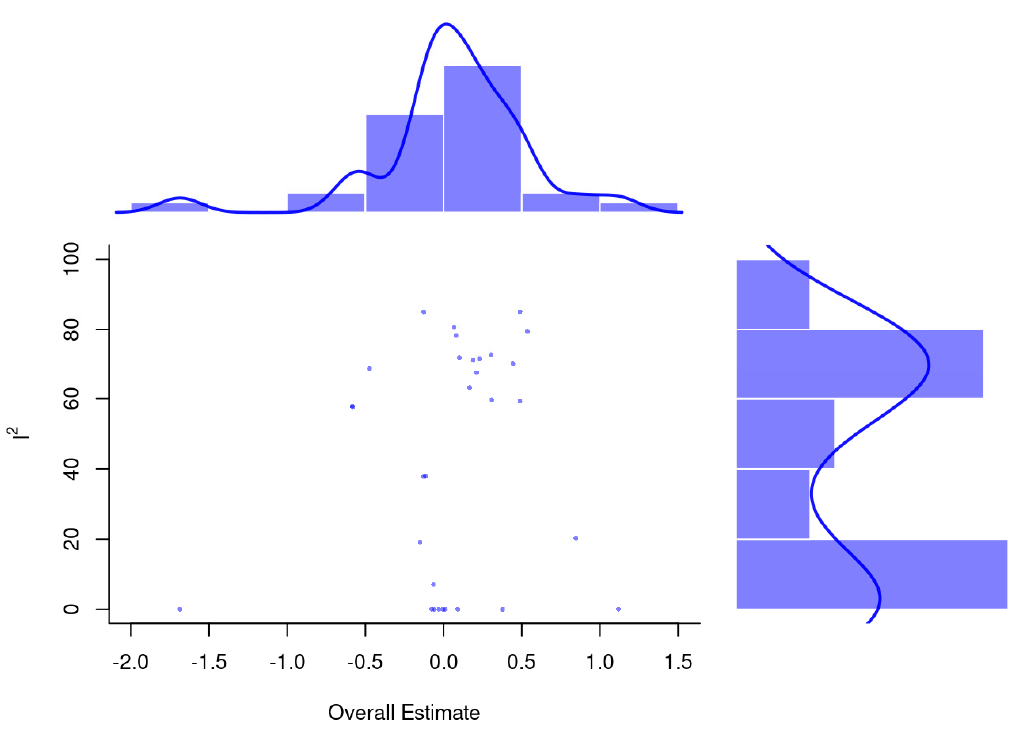
Figure A5. GOSH plot. I 2 : proportion of the variance in observed effect is due to variance in true effects rather than sampling error.